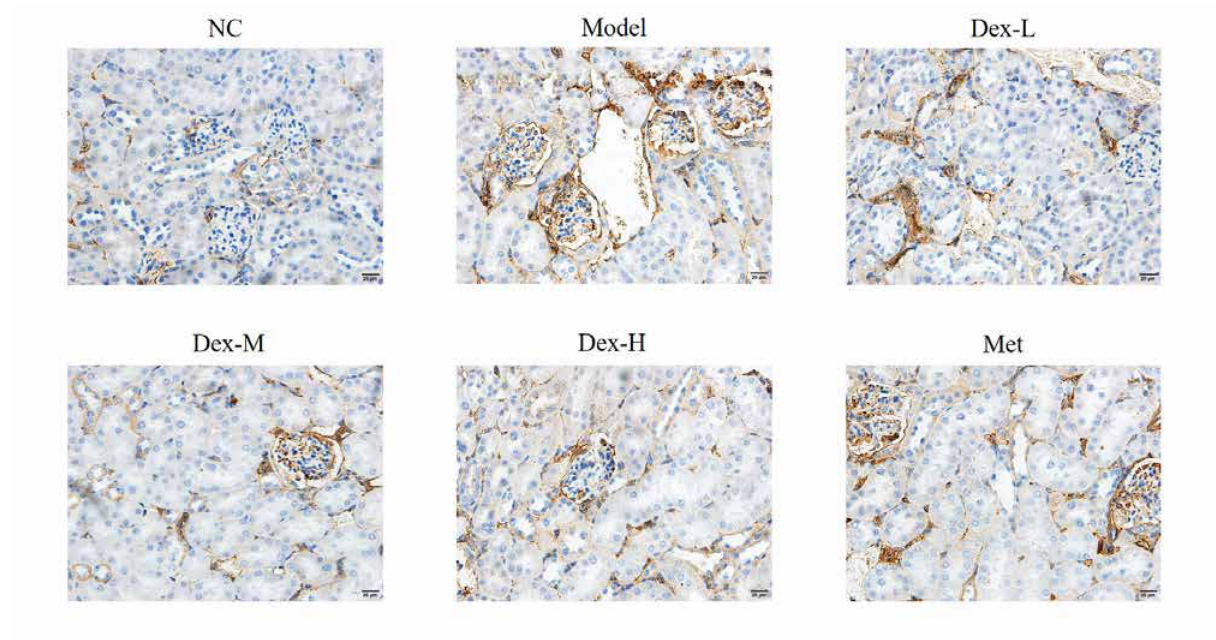
Figure 10: The α-SMA protein expression of different groups by IHC assay (400×) NC: normal control group; Model: DN model group; Dex-L: Dex low-dose treated group; Dex-M: Dex medium-dose treated group; Dex-H: Dex high-dose treated group; Met: Metformin treated